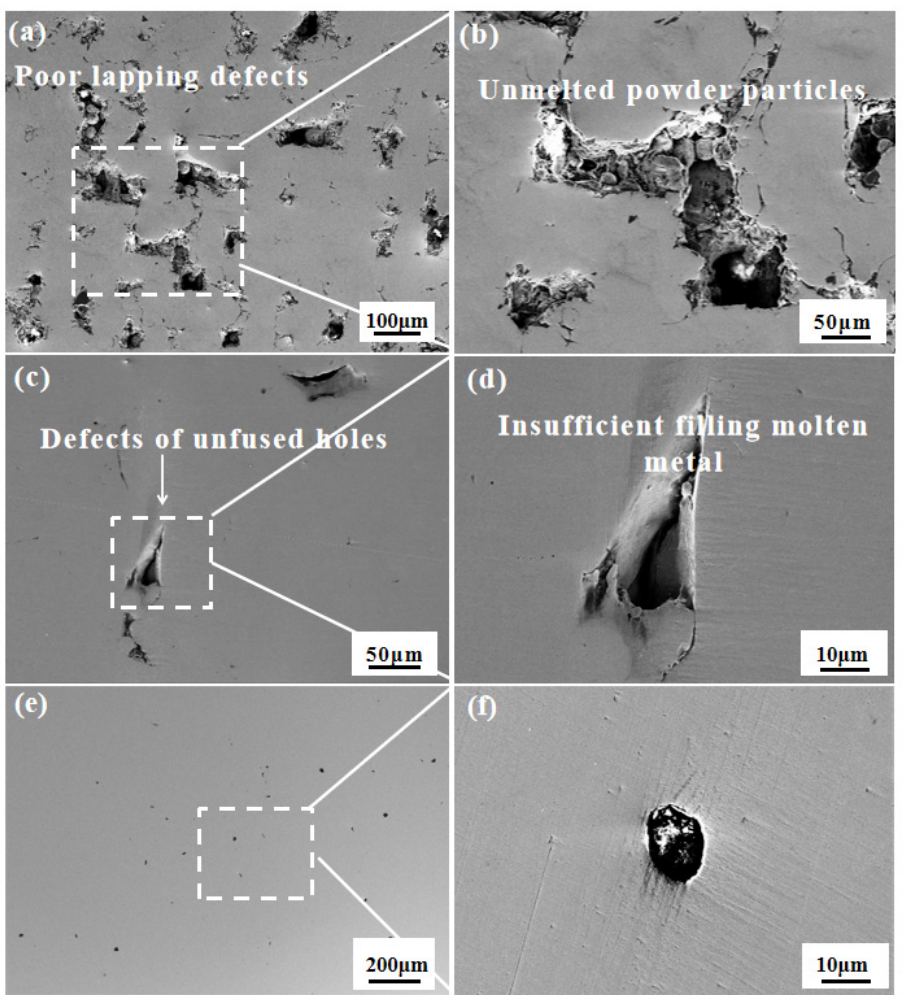
Figure 9. SEM images of chemically etched surface of 316 L stainless steel via LPBF for different laser energy densities. ( a ) Sample 3; ( b ) enlargement of the white rectangle area in ( a ); ( c ) sample 2; ( d ) enlargement of the white rectangle area in ( c ); ( e ) sample 4; ( f ) enlargement of the white rectangle area in ( e ).